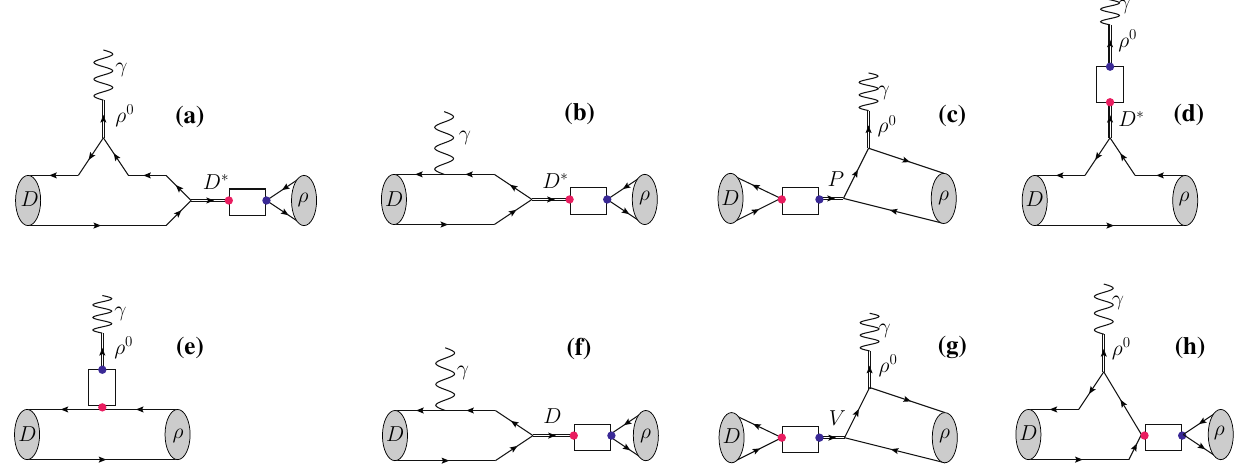
Fig. 3 Skeleton diagrams for the long-distance amplitudes which contribute to the D → ργ decay. The rectangle denotes the weak transition which can be described with the help of the effective